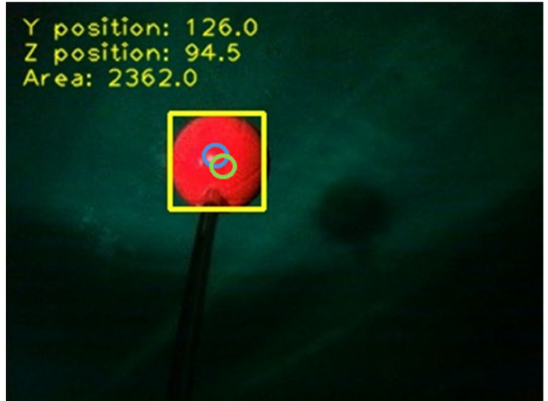
Figure 11. The recognition results of the image with the